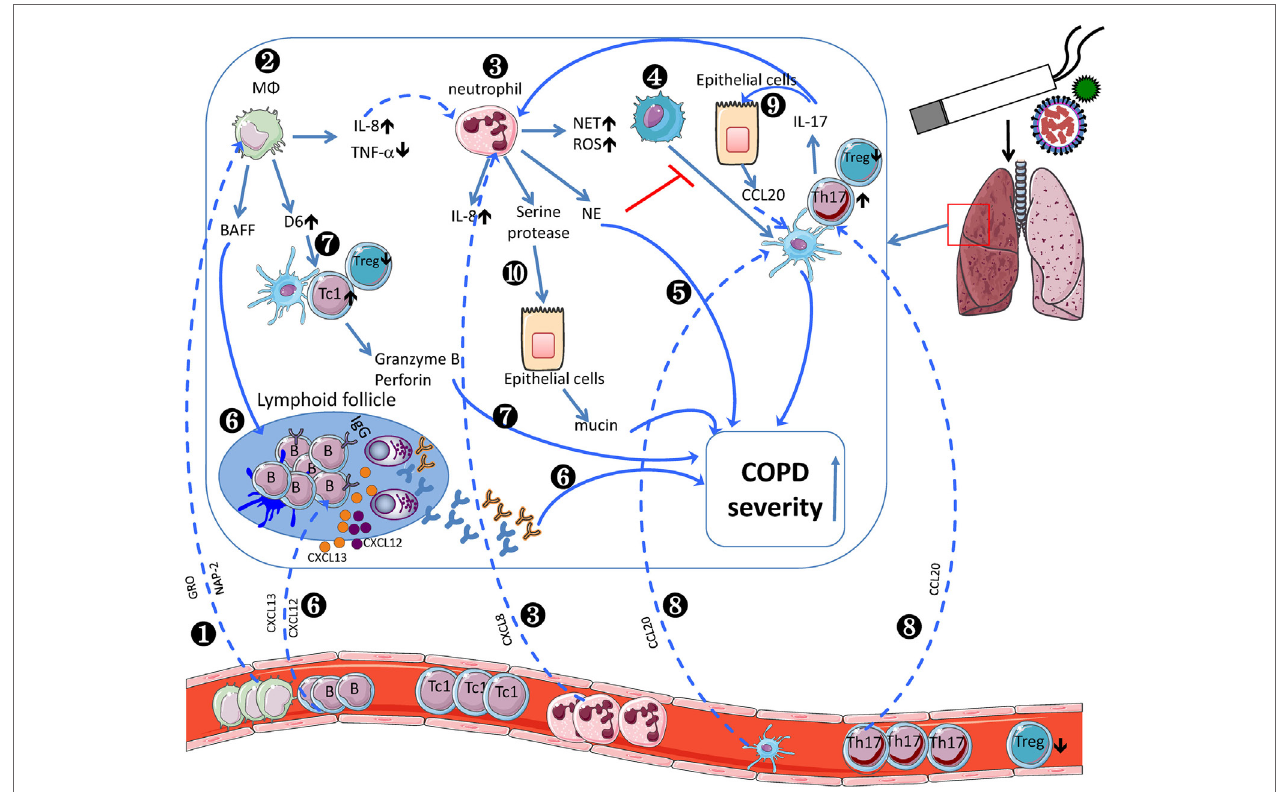
FigURe 1 | Inflammatory cells involved in the pathogenesis of chronic obstructive pulmonary disease (COPD). COPD monocytes leave the circulation, migrate into the lung, and differentiate into M2-like macrophages by sensing growth-related oncogene (GRO)/CXCL1 and neutrophil-activating peptide (NAP)-2/CXCL7 ( ➊) . In lung, cigarette smoke extract (CSE) induces alveolar macrophages (AMs) to produce IL-8/CXCL8 ( ➋ ), which recruits circulating neutrophils ( ➌ ). Neutrophils produce neutrophil elastase to inhibit dendritic cell (DC) maturation ( ➍ ) and decline pulmonary function ( ➎ ). Moreover, AM-induced BAFF could promote B cell development and lymphoid follicle maintenance ( ➏ ), which recruit peripheral B cells via BLC/CXCL13 or SDF1/CXCR12. Activated B cells produce a large amount of antibodies ( ➏ ), leading to exacerbated COPD severity. AM-expressing D6 promotes granzyme B and perforin-expressing TC1 response, which exacerbate COPD severity ( ➐ ). In another aspect, COPD epithelial cells secret MIP-3 α/ CCL20, resulting in increased recruitment of dendritic cells and Th17 ( ➑ ). IL-17F further promotes lung epithelial cells to secret CCL20 ( ➒ ). Neutrophil-derived serine protease induces epithelial cells to secrete more mucin to exacerbate COPD severity ( ➓ ). The crosstalk between adaptive and innate immune cells contributes to the pathogenesis of